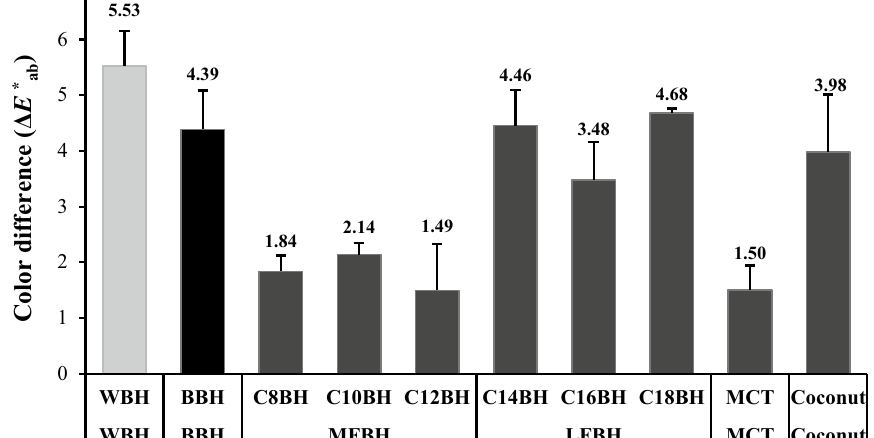
Fig. 5 Color difference ( (cid:31) E ∗ ab ) of bleached hair (BH) after 21 days of applying different hair